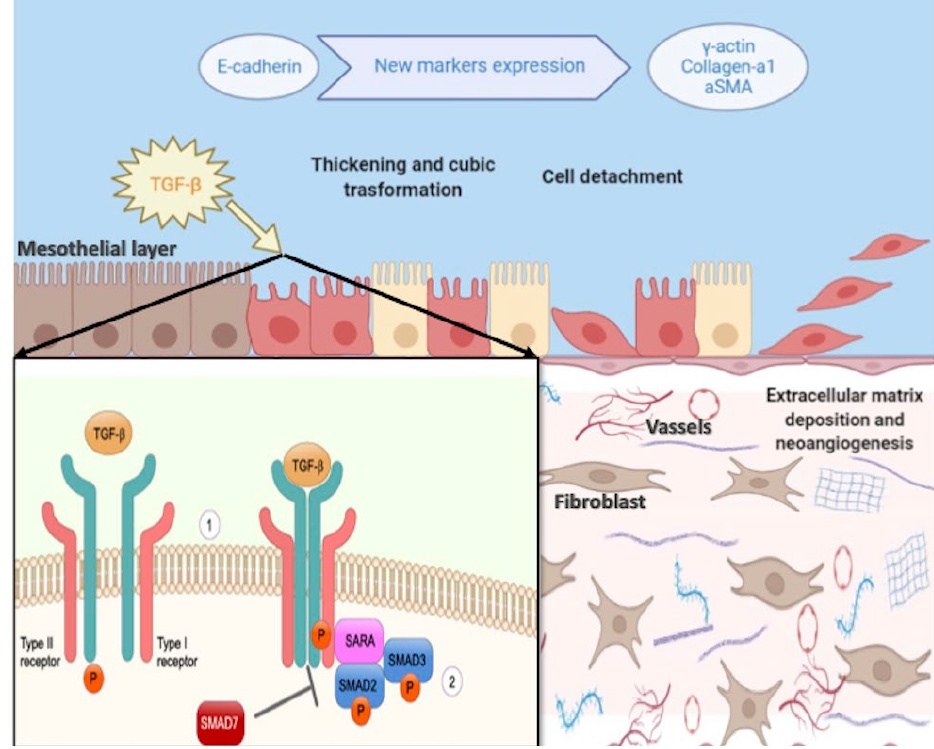
Figure 1. Epithelial to mesenchymal transition of peritoneal membrane. A schematic representation of the peritoneal membrane composed of mesothelial cells monolayer and extracellular matrix within vessels and fibroblast and the progressive change of the structure due to epithelial-to-mesenchymal (EMT) transition. Moreover, the main markers that characterize the phenotype switch of mesothelial cells to fibroblast-like phenotype due to EMT are represented and reported. In the mirror below on the left, the most significant intracellular pathways of the TGF- β signaling are represented: (1) Dimeric TGF- β receptor type I and II before binding the ligand. (2) TGF- β binds receptors and, through phosphorylation, activates SMADs and Shad anchor for receptor activation (SARA) complexes. (TGFβ = transforming gro wth factor 1- β, αSMA = α smooth muscle actin) .